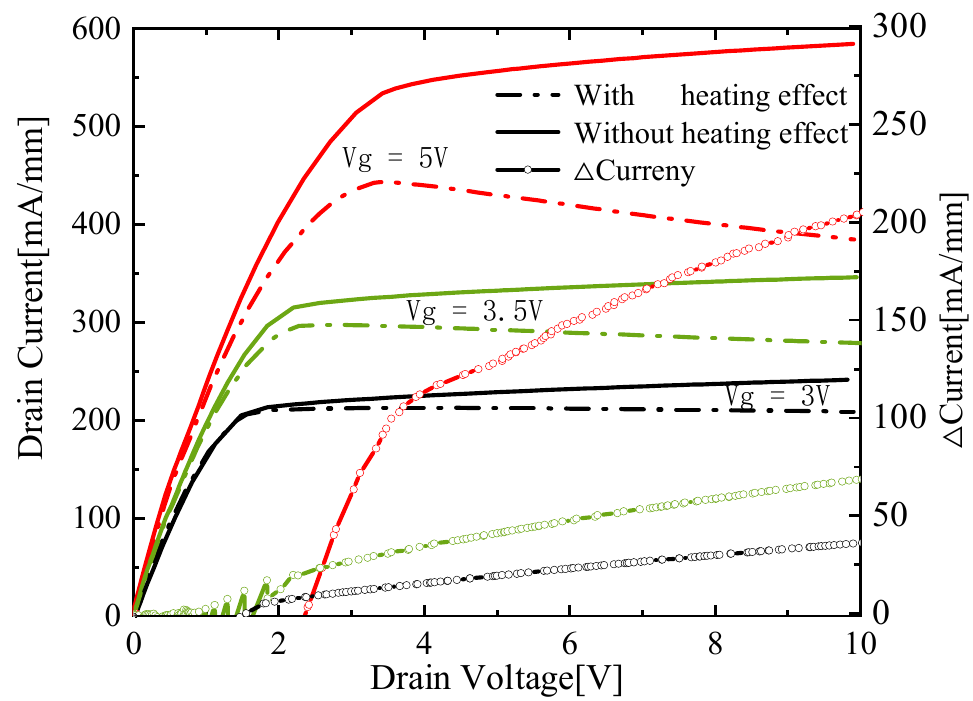
Figure 6. Diagram of drain current with drain voltage for various values of gate voltage with self- heating (solid line, left Y-axis), without self-heating (dotted line, left Y-axis), and ∆ current (solid line with hollow circle, right Y-axis).